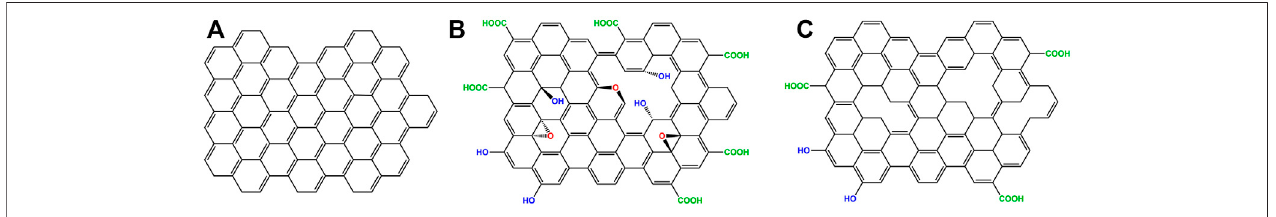
FIGURE 1 | Graphene, GO and rGO structures (A) Graphene is a single layer of carbon atoms arranged in a honeycomb lattice. (B) Graphene oxide (GO), has hydrophilicgroupscontainingoxygenprotruding outsideitsplaneand edges. (C) Reduced grapheneoxide(rGO)hasfewer hydrophilicgroupscomparedtoGO,dueto a reduction process. Contrarily to pristine graphene, the carbon atoms of GO and rGO do not lie in the same plane due to the presence of structural defects.